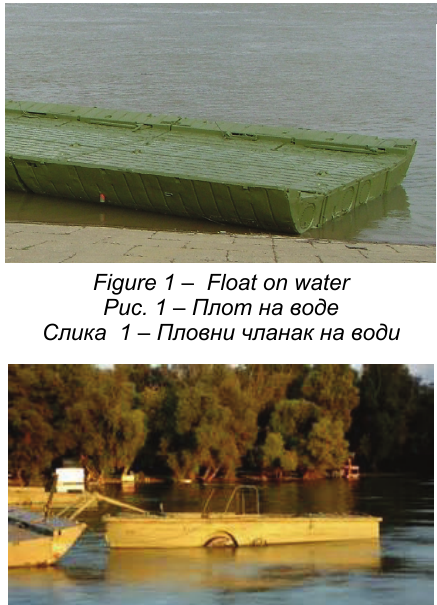
Figure 2 – Tug RPP M88 Рис . 2 – Буксирное судно РПП М 88 Слика 2 – Реморкер РПП М